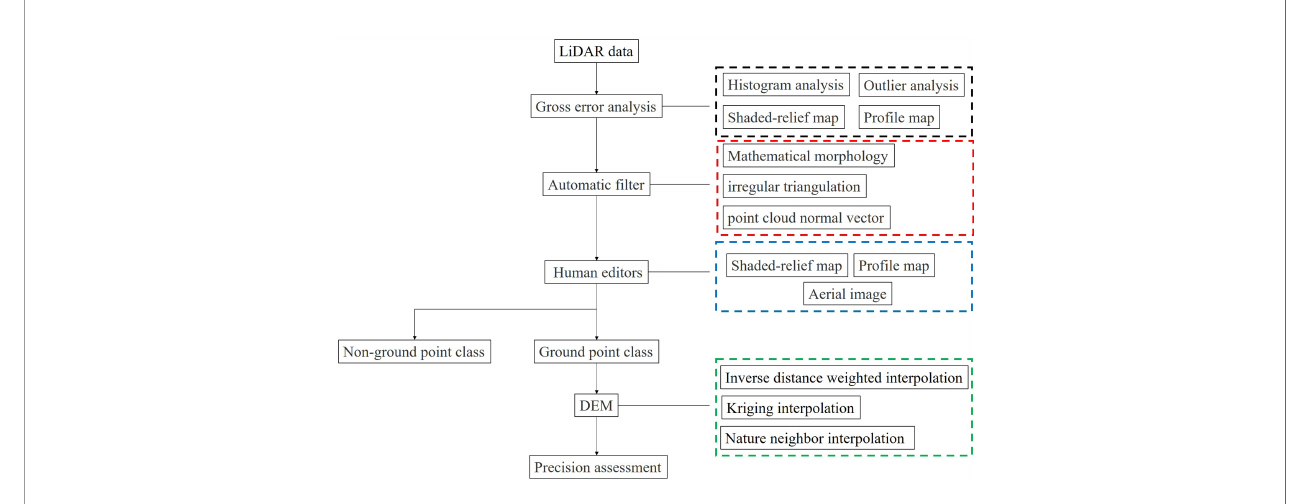
FIGURE 4 | The fl ow chart of airborne LiDAR data processing.